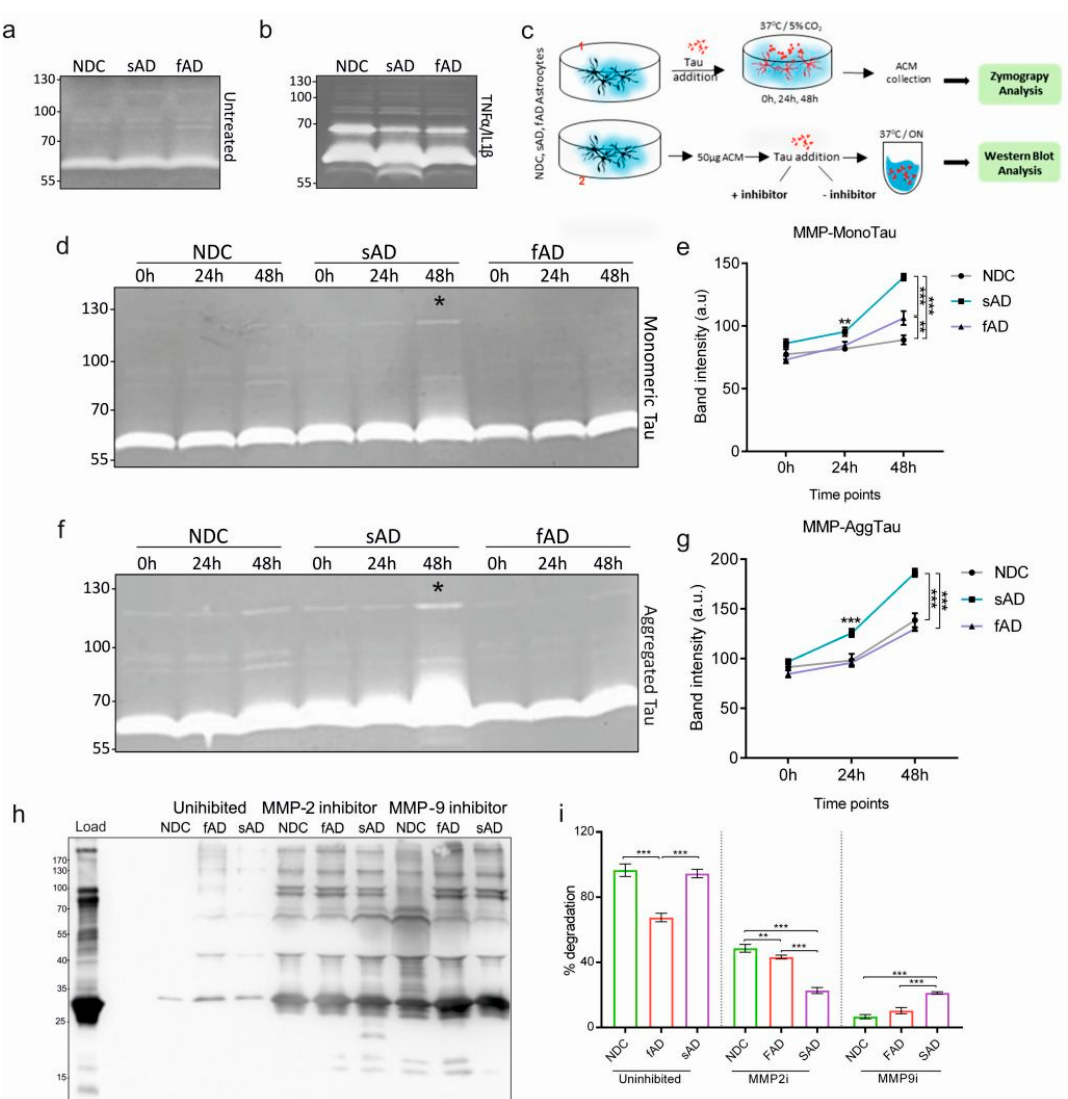
Figure 6. Astrocytes derived from sporadic Alzheimer’s disease iPSCs show higher gelatinase activity. ( a ) Representative zymograph image using astrocyte-conditioned media (ACM) from control, sporadic and familial iPSC-derived astrocytes. ( b ) Representative zymograph image of ACMs from control, sporadic and familial iPSC-derived astrocytes pretreated with TNF α and IL1 β . ( c ) Schematics showing experimental design for the detection of MMPs and tau degradation analysis. ( d ) Representative zymograph image using ACM from control, sporadic and familial AD astrocytes treated with monomeric tau for 0 h, 24 h and 48 h. Note the moderate increase in gelatinase activity at 48 h of ACM from sAD astrocytes (asterisk). ( e ) Graphs showing difference in MMP activity after exposure to monomeric tau between the ACM from three groups. ( f ) Representative zymograph image using ACM from NDC, sporadic and familial AD astrocytes treated with aggregated tau for 0 h, 24 h and 48 h. Increase in gelatinase activity at 48 h of ACM from sAD astrocytes was observed (asterisk). ( g ) Graph showing difference in gelatinase activity of MMPs after exposure to aggregated tau between the three groups. ( h ) Degradation of aggregated tau by proteases in the ACM from three different iPSC-derived astrocytes. The protease activity is selectively inhibited by MMP2 and MMP9 inhibitors. ( i ) Graph showing percentage of tau degradation between the groups. One-way ANOVA followed by Tukey’s multiple comparisons tests, n = 3/group; n = 3 experimental repeats, * p < 0.05, ** p < 0.01, and *** p < 0.001.